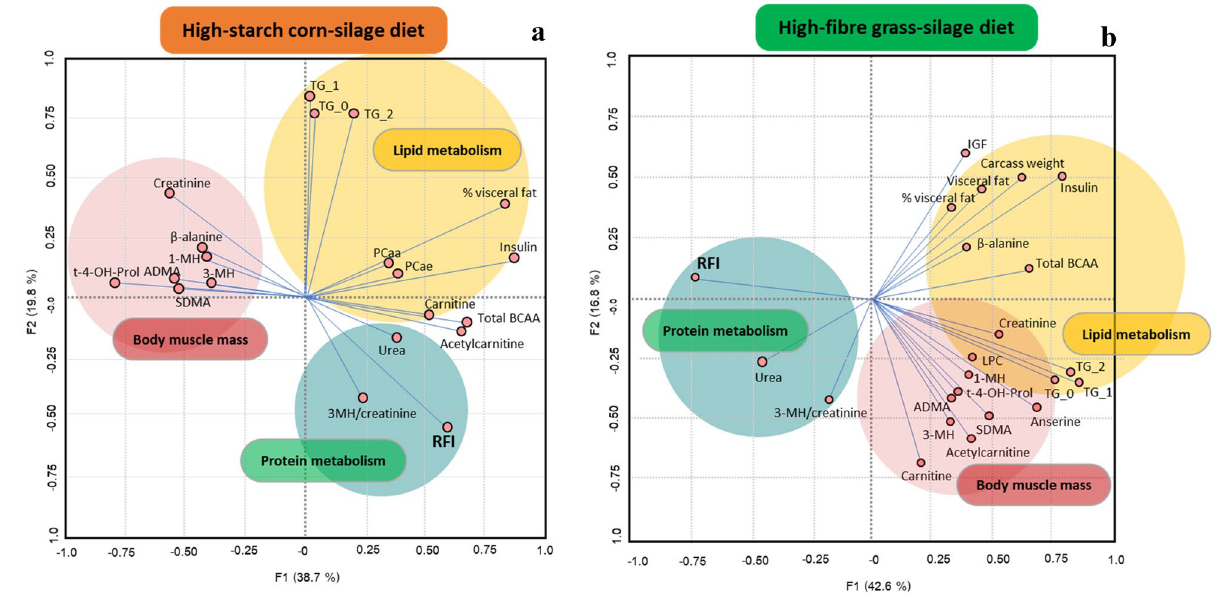
Figure 2. Loading plots of principal component analysis conducted a posteriori according to variables highly involved in shared and diet-dependent metabolic pathways underlying RFI variation in corn- ( a ) and grass- silage ( b ) diets. TG_n denote triglycerides with increasing saturations (0, 1, or more for TG_0, TG_1 and TG_2, respectively); t-4-OH-Prol: trans-4-hydroxyproline; 3MH/creatinine: 3-methylhistidine to creatinine ratio;